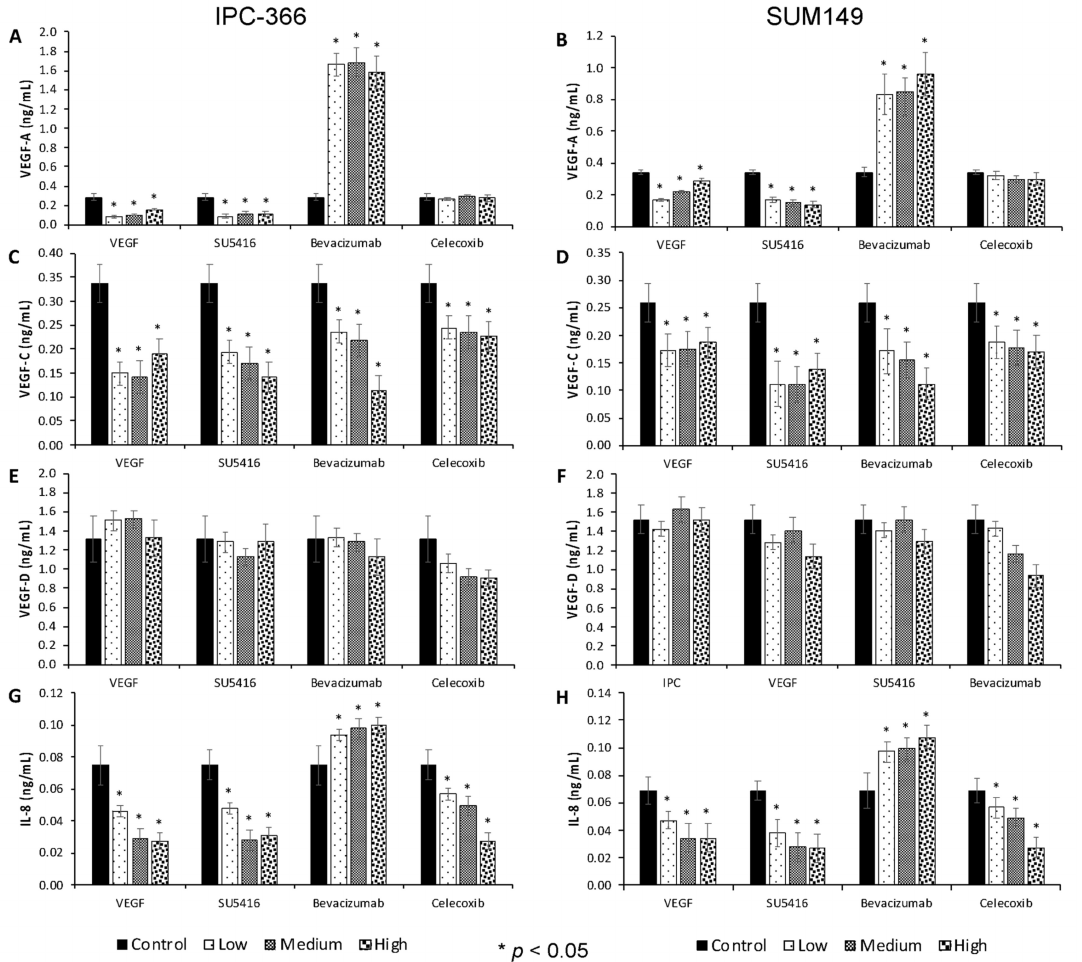
Figure 3. Angiogenic growth factors and interleukin IL-8 concentrations in culture media of control and treated IPC-366 and SUM-149 cells at 72 h after the addition of low, medium and high concentrations of VEGF (0.62 uM; 1.25 uM and 2.5 uM); SU5416, bevacizumab and celecoxib (1.5 uM, 3 uM, and 6 uM). ( A , B ) Vascular endothelial growth factor A (VEGF-A). ( C , D ) Vascular endothelial growth factor C (VEGF-C). ( E , F ) Vascular endothelial growth factor D (VEGF-D). ( G , H ) Interleukin-8 (IL-8). Bar represents means ± SEM. * Significant differences between control and treatment groups ( p <